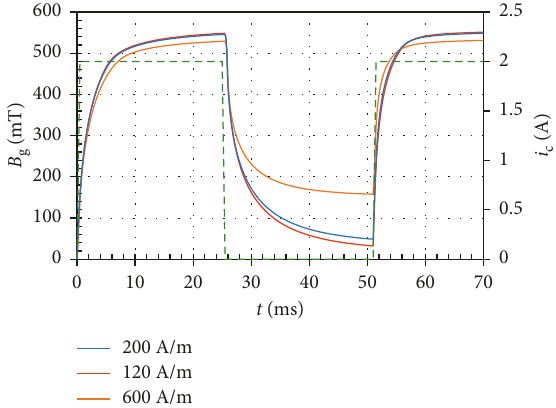
Figure 27: Coercivity H c : (gap) averaged magnetic flux density time